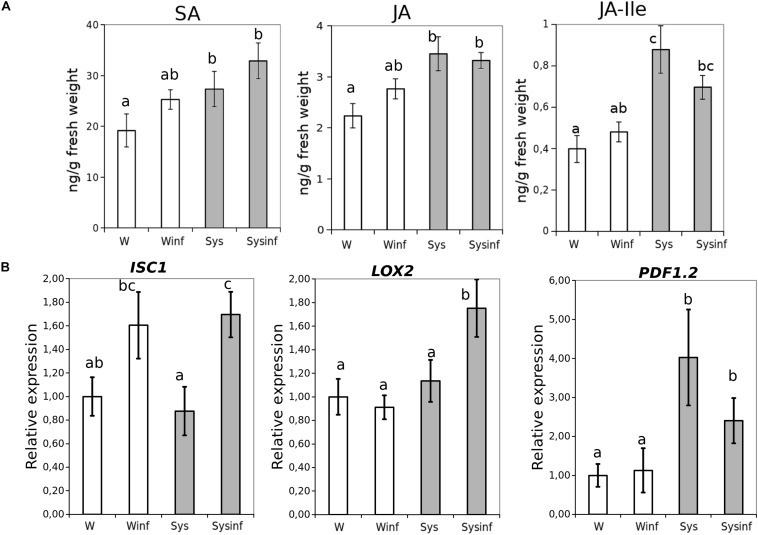
Systemin treatment impact in hormonal profiles. (A) Salicylic acid (SA), Jasmonic acid (JA) and JA-isoleucine (JA-ile) hormone quantitative levels (ng/g fresh weight) measured in Arabidopsis seedlings 48 h after P. cucumerina infection in control (W) control infected (W inf) 24 h Systemin-pretreated (Sys) and 24 h Systemin-pretreated infected (Sys inf) plants by targeted HPLC-MS analysis. (B) Quantitative reverse transcription-polymerase chain reaction analysis of ICS1, LOX2, and PDF1.2 in seedlings 48 h after P. cucumerina infection in Water plants “W,” water infected plants “W inf,” 0.1 nM Systemin treated plants “Sys” and Sys infected plants “Sys inf.” Bars represent mean ± standard error (SD), n = 6. Different letters represent statistically significant differences. (ANOVA, Fisher’s Least Significant Difference (LSD) test; P < 0.05, n = 6).